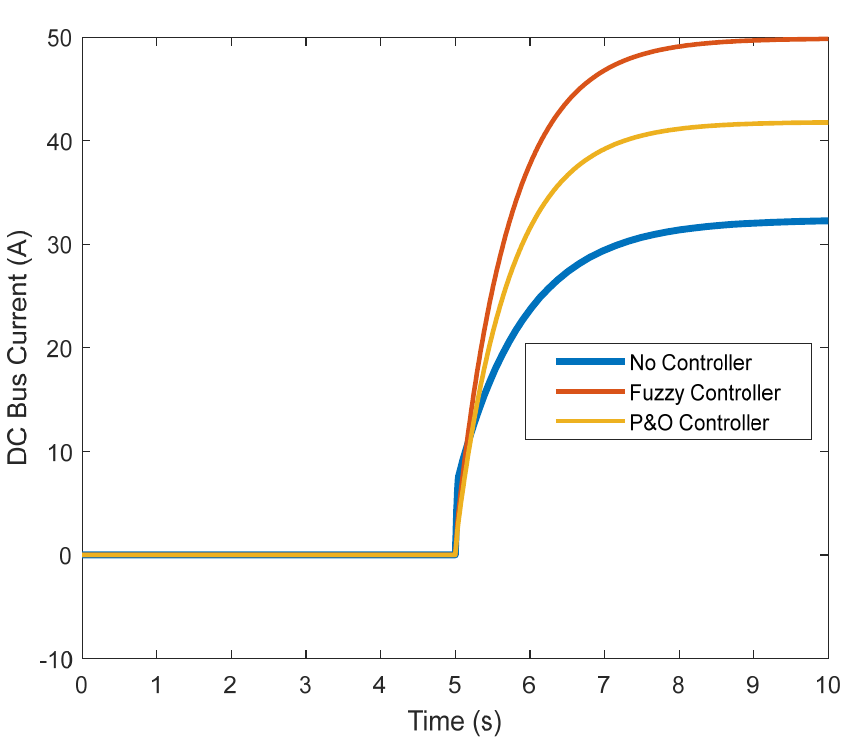
Figure 19. DC link current in the transient state.